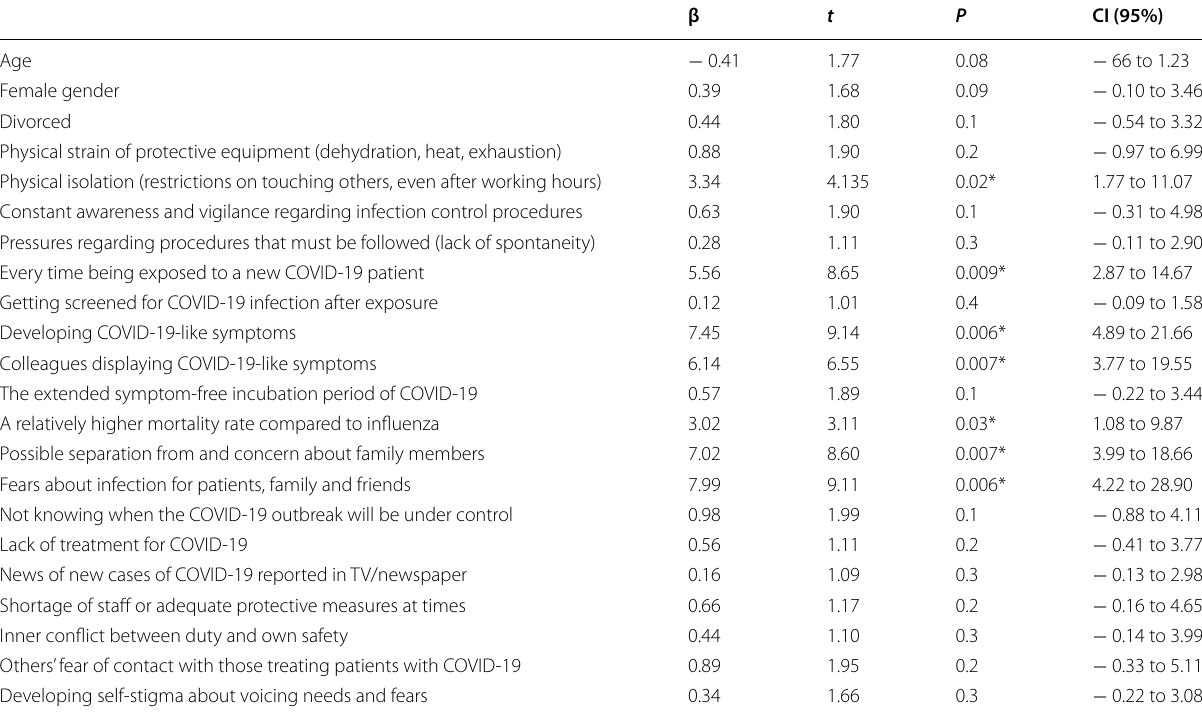
Table 4 Linear regression analysis of factors independently associated with PHQ-9 score among nurses exposed to